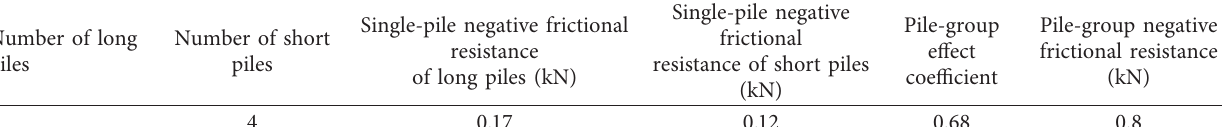
Table 5: Negative frictional resistance Q n g of the pile group consisting of 8